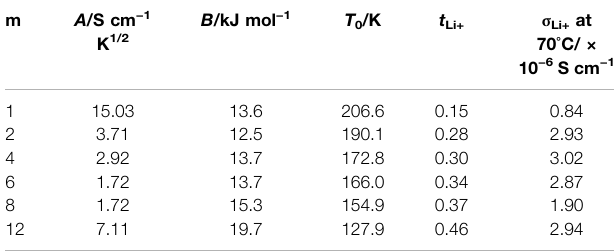
A is a fi tting parameter relevant to the number of charge carriers, B is the pseudo activation energy of ion conduction, and T 0 is an ideal glass transition